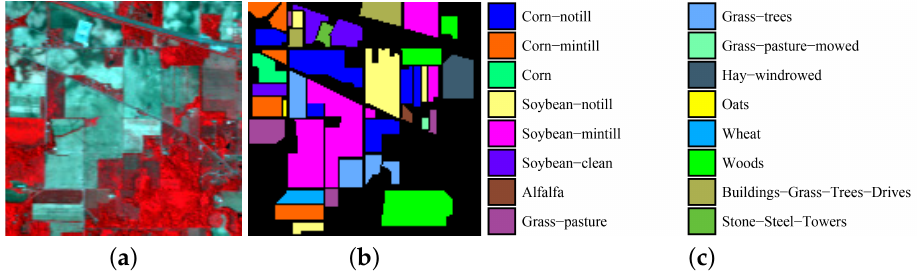
Figure 2. Indian Pines data set. ( a ) false-color composite; ( b , c ) ground truth data.